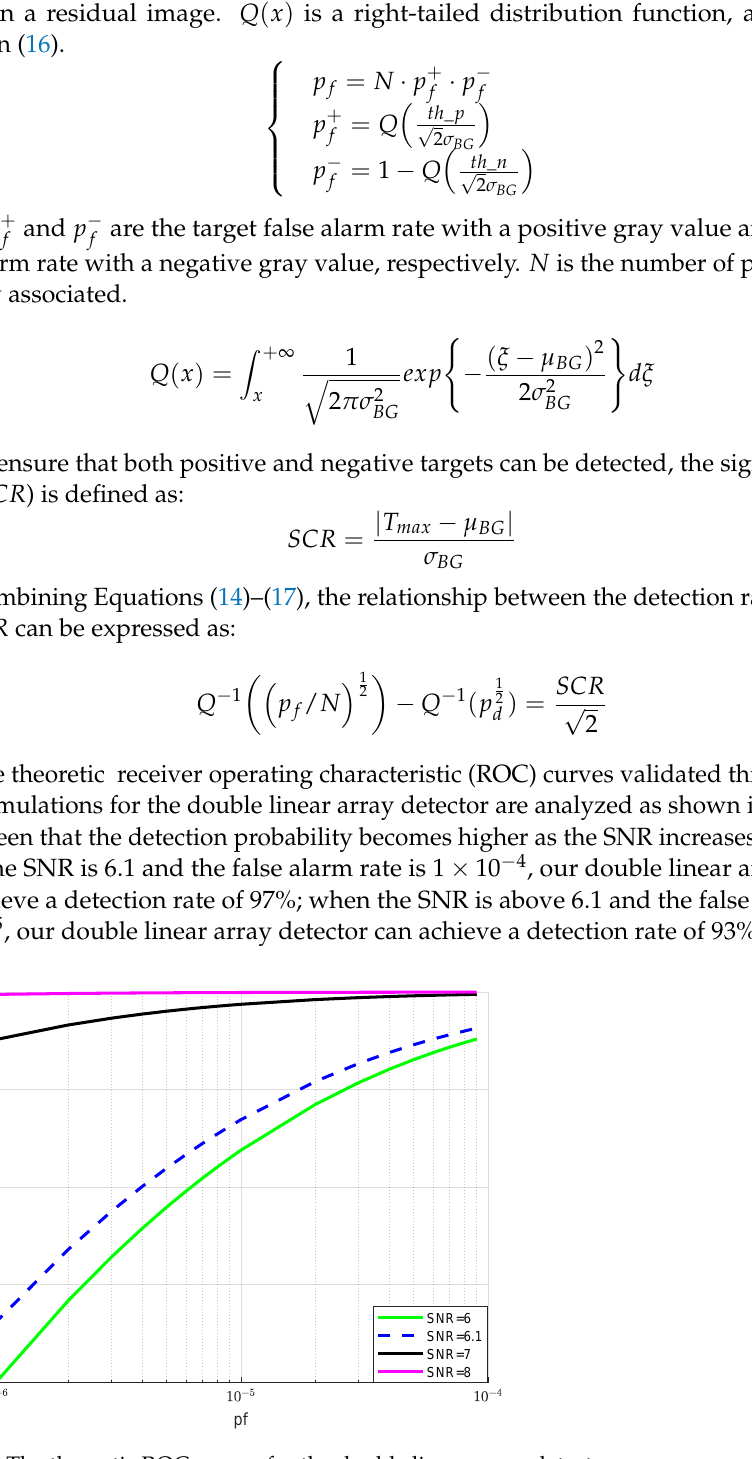
Figure 6. The theoretic ROC curves for the double linear array